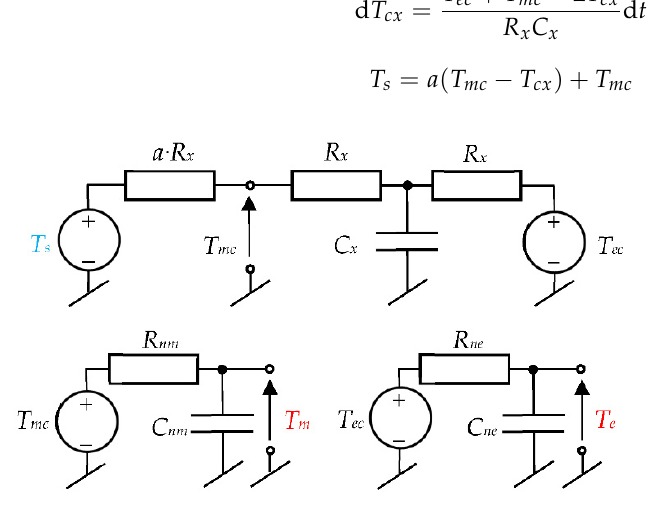
Figure 11. Final thermal models of the sensors and clothing. The input quantities are given in red, and the output in blue.